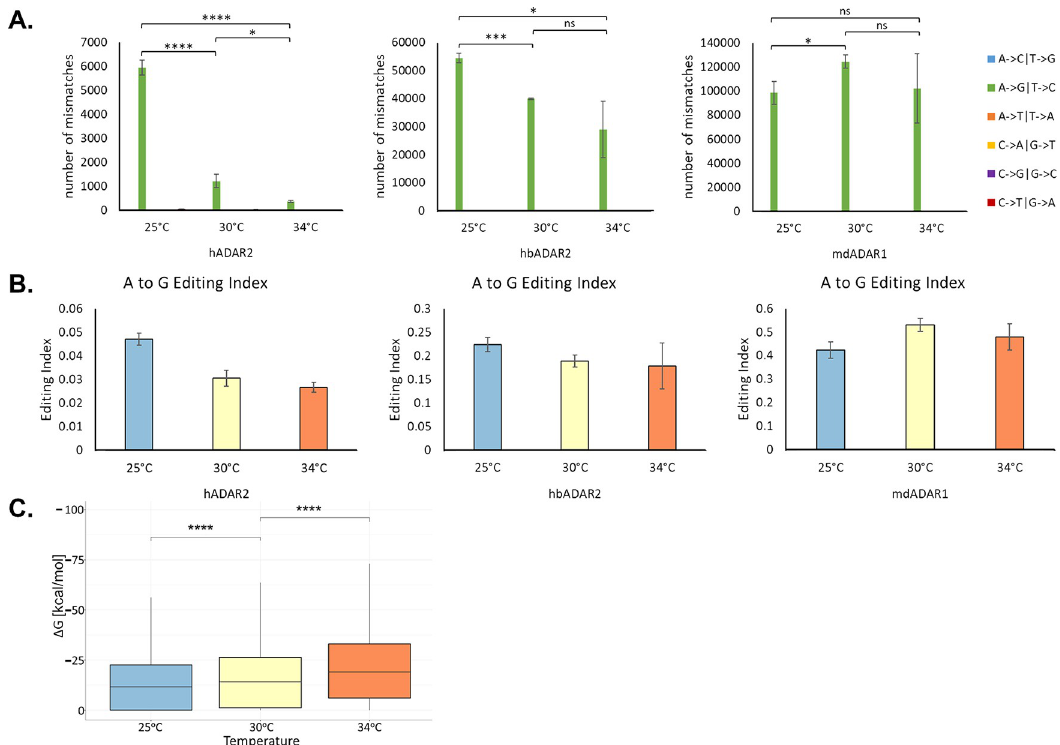
Fig 6. Temperature dependence of editing in ADAR-expressing yeast strains. (A) Res-scanner detection of editing sites (Methods) demonstrates a clear negative correlation between the growth temperature and editing activity for hADAR2 and hbADAR2. The strain expressing mdADAR1, where the impact of editing is much more extensive and severe, exhibits a more complex behavior. (B) The same picture emerges looking at the genome-wide editing index. (C) Thermodynamic stability of the predicted secondary structures surrounding the detected sites edited by hADAR2 (Methods). For each temperature, sites detected in at least once replicate were included. For the sake of comparison, all structures were calculated for 30˚C. Lower (more negative) Δ G indicates a more stable structure. Note that no structure was found for 2727, 537 and 111 sites, for T = 25˚C, 30˚C and 34˚C, respectively. Their Δ G was set to zero. (ns: p > 0.05; � : p < = 0.05; �� : p < = 0.01; ��� : p < = 0.001; ���� : p < =